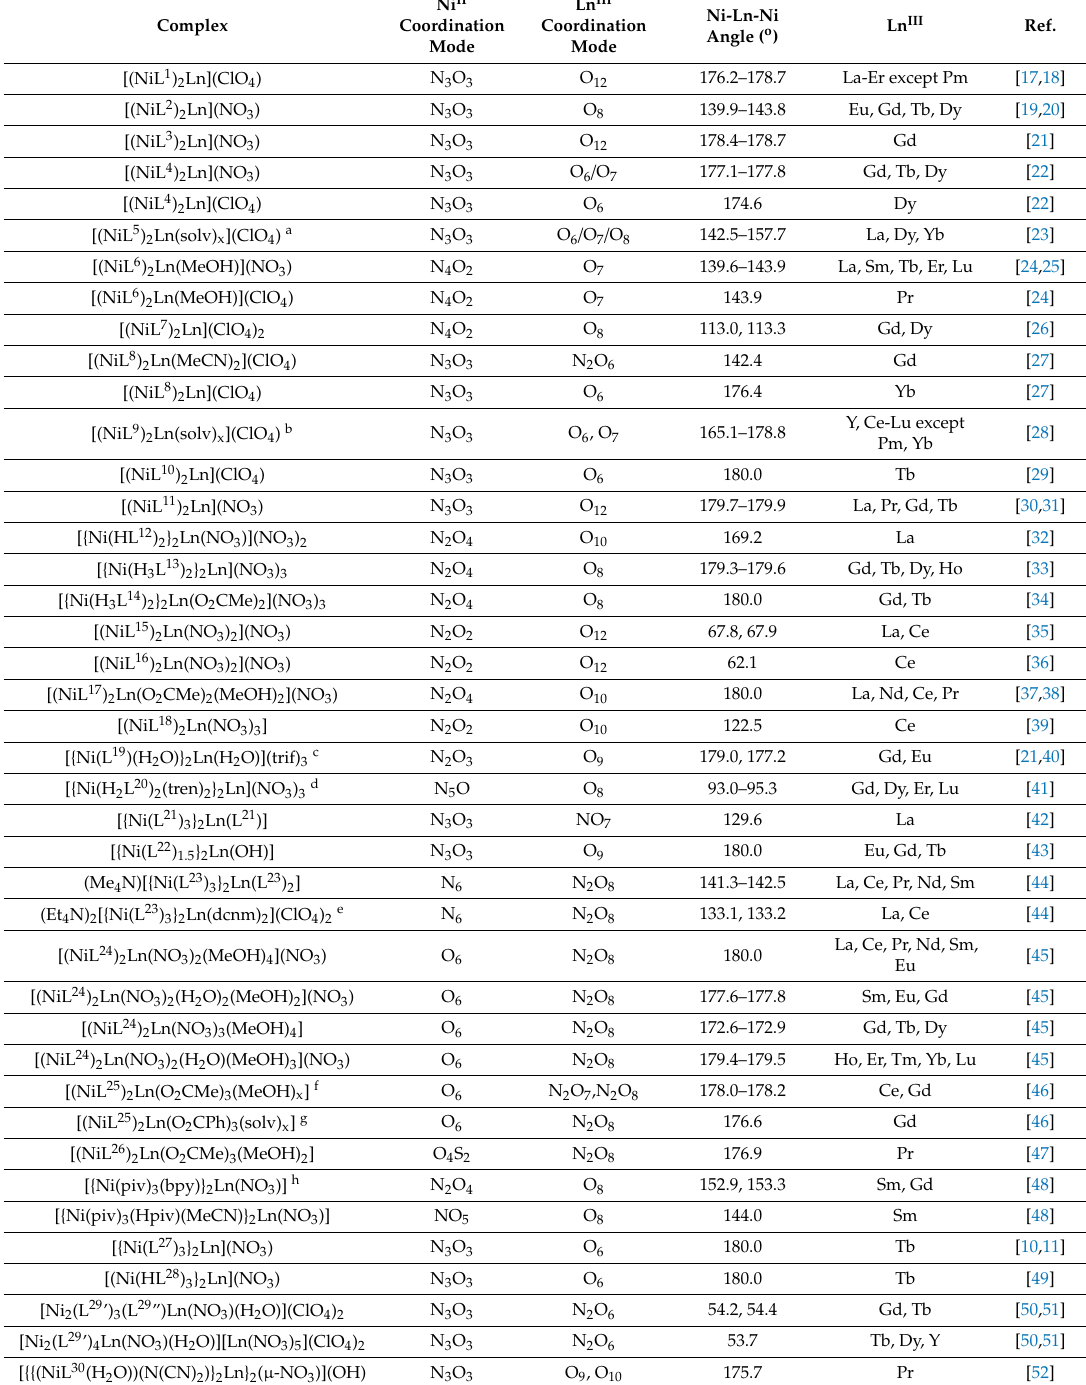
Table 1. Structural characteristics of the crystallographically studied Ni 2 Ln complexes.